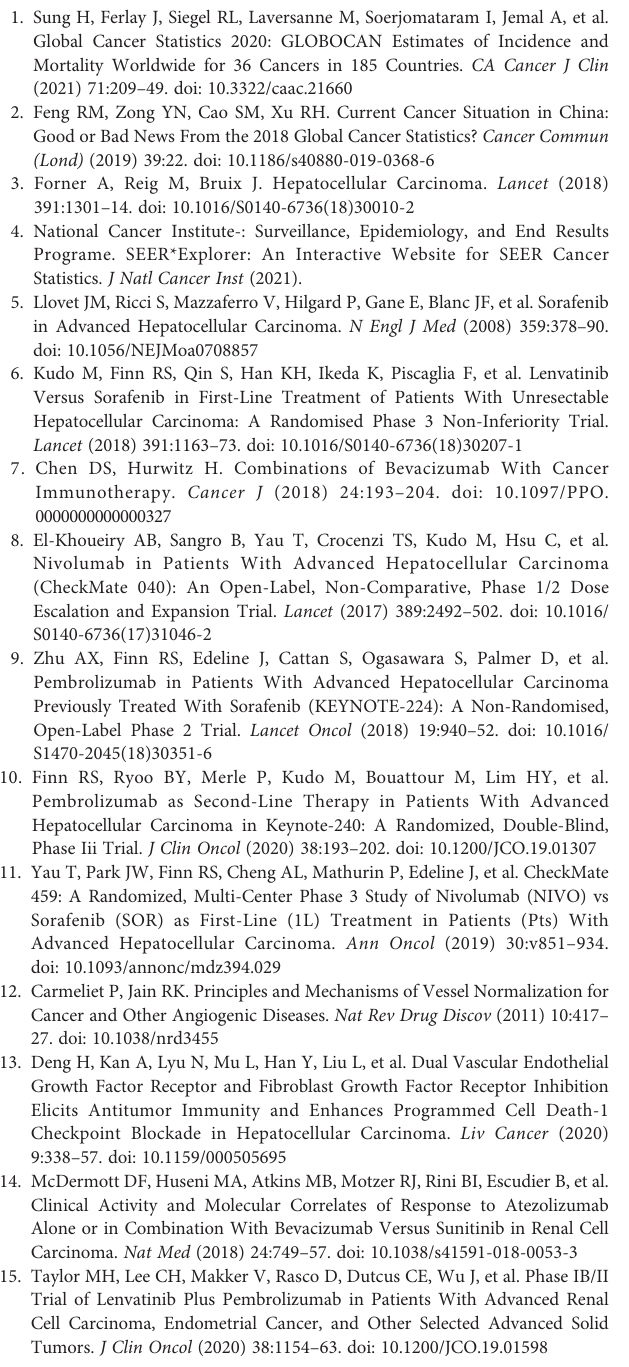
Supplementary Figure 2 | Box and whisker graphs show the proportion of CD16 + CD56 + NK cells in the plasma at baseline of HCC patients who achieved CR or PR (left) or who had SD or PD (right). Boxes represent the 25 th to 75 th percentiles, and whiskers extend to the highest and lowest values within 1.5× the upper/lower quartile distance, with outliers shown as